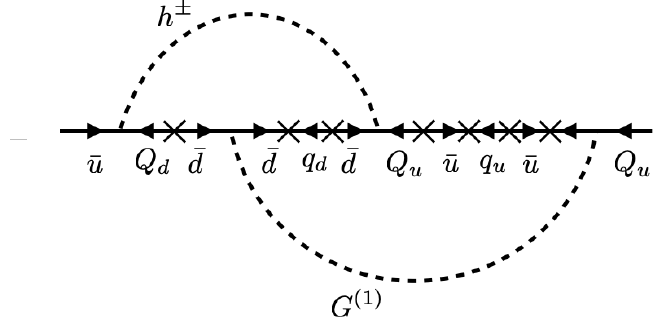
Figure 3 . A two-loop diagram involving h ± and the first KK excitation of the gluon G (1) . Here, ¯ d , ¯ u , q d and q u include KK excitation modes as well as zero modes. Q u,d , respectively, denote the up and down-type quark components of Q . We have omitted the flavor indices for notational simplicity. The solid lines represent fermion lines, and the dashed lines denote boson lines including gauge bosons and